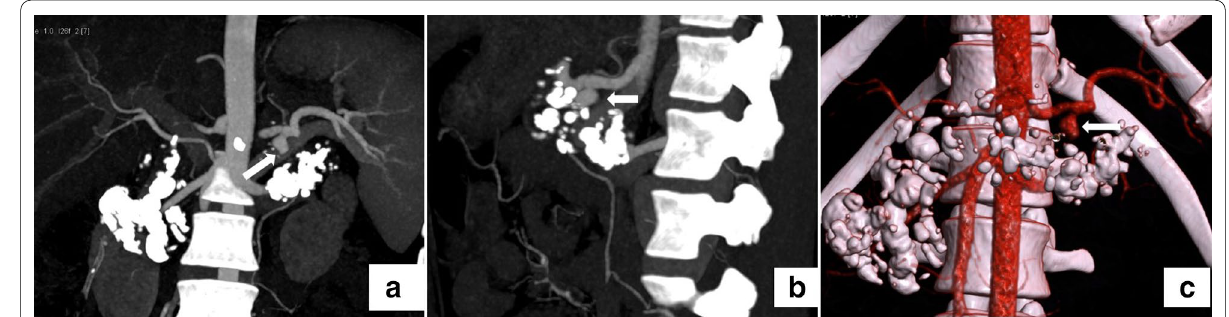
Fig. 1 CECT abdomen arterial phase with maximum intensity projection (MIP) coronal ( a ), MIP sagittal ( b ), and volume rendering technique (VRT) coronal ( c ) images showing a pseudoaneurysm (white arrow) arising from the mid-segment of splenic artery